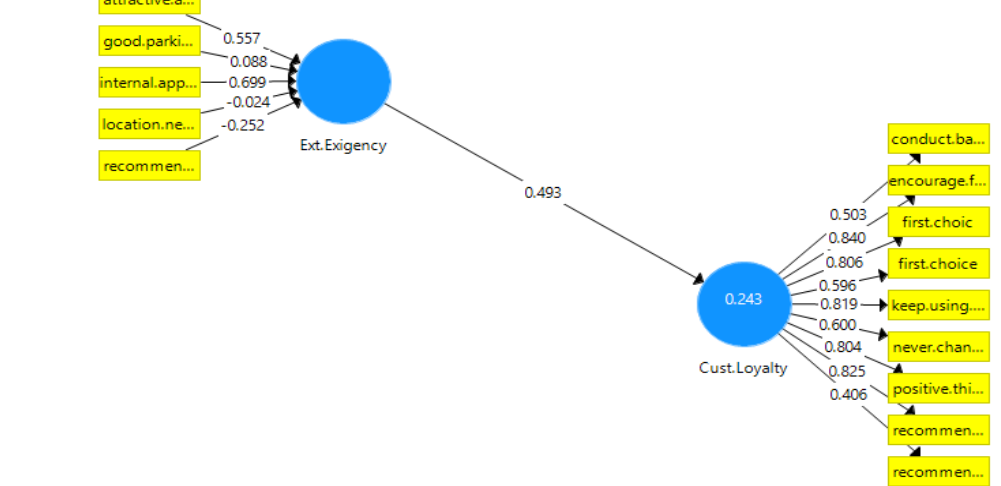
Figure 1: PLS-SEM model indicating the influence of External Exigencies on Customer